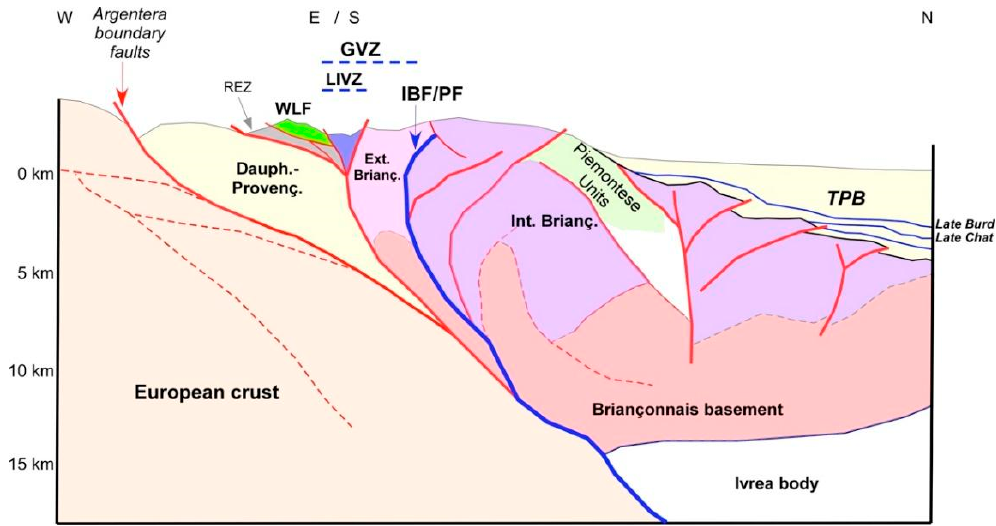
Figure 2. Schematic geological section (location in Figure 1) across the Argentera massif, the western Ligurian Alps and the TPB syn-orogenic basin. Reference data from [17,23,25,26,64,65]. Legend: TPB: Tertiary Piemonte Basin; GVZ: Gardetta-Viozene Zone; LIVZ: Limone-Viozene Zone; REZ: Refrey Zone; WLF: Western Ligurian Flysch (Helminthoides Flysch); IBF/PF: Internal Briançonnais Front/Penninic Front; Late Burd, Late Chat: seismic imaged unconformities of inferred late Burdigalian and late Chattian age.